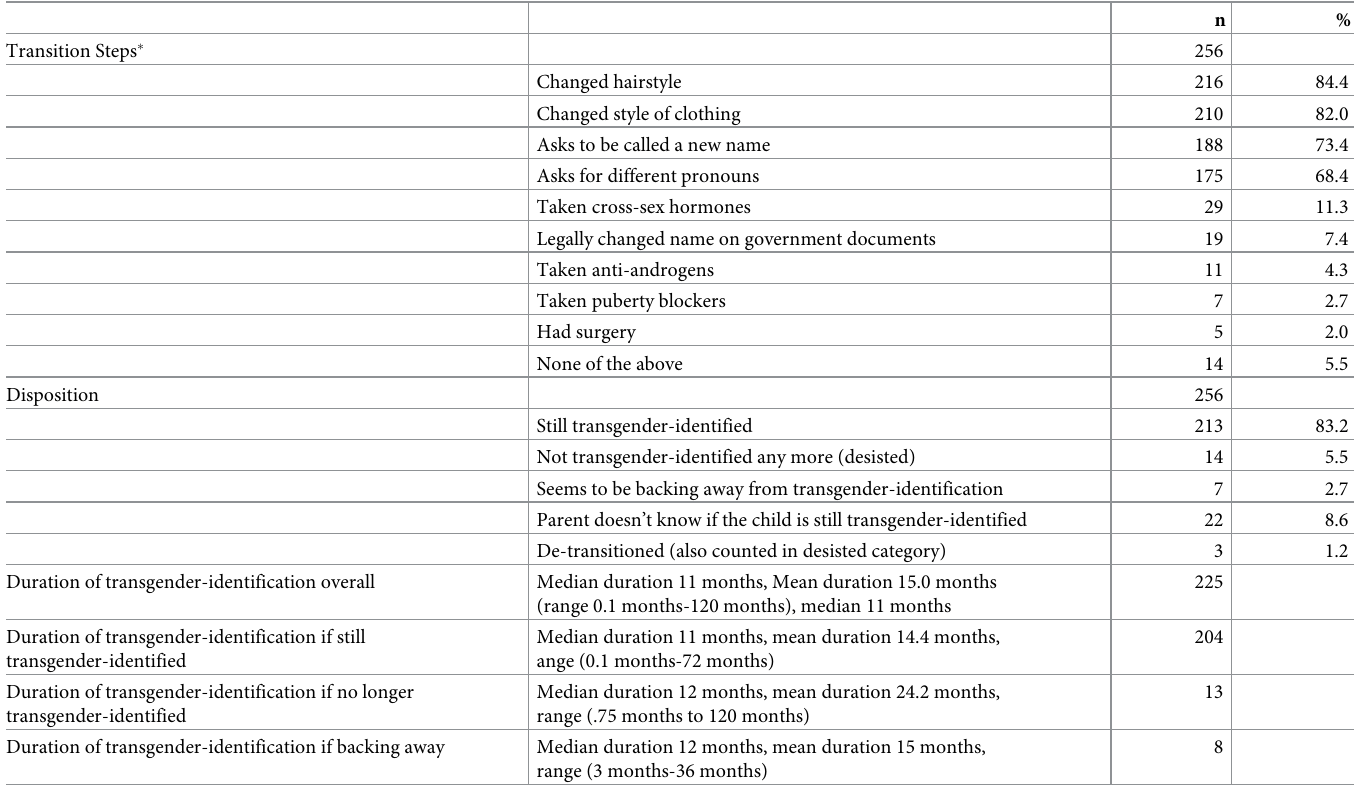
Table 12. Transition steps and